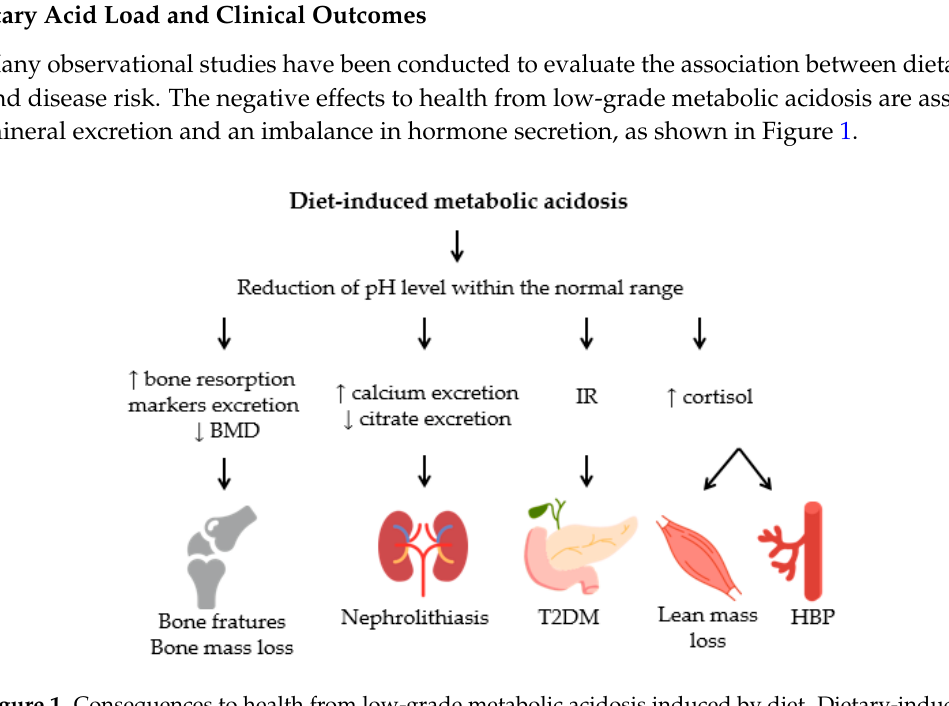
Figure 1. Consequences to health from low-grade metabolic acidosis induced by diet. Dietary-induced low-grade metabolic acidosis may predispose to various disorders including bone metabolism impairment, kidney stone formation, loss of lean mass, increased systemic blood pressure, and risk of type 2 diabetes mellitus. BMD: bone mineral density; IR: insulin resistance; T2DM: type 2 diabetes mellitus; HBP: high blood pressure.